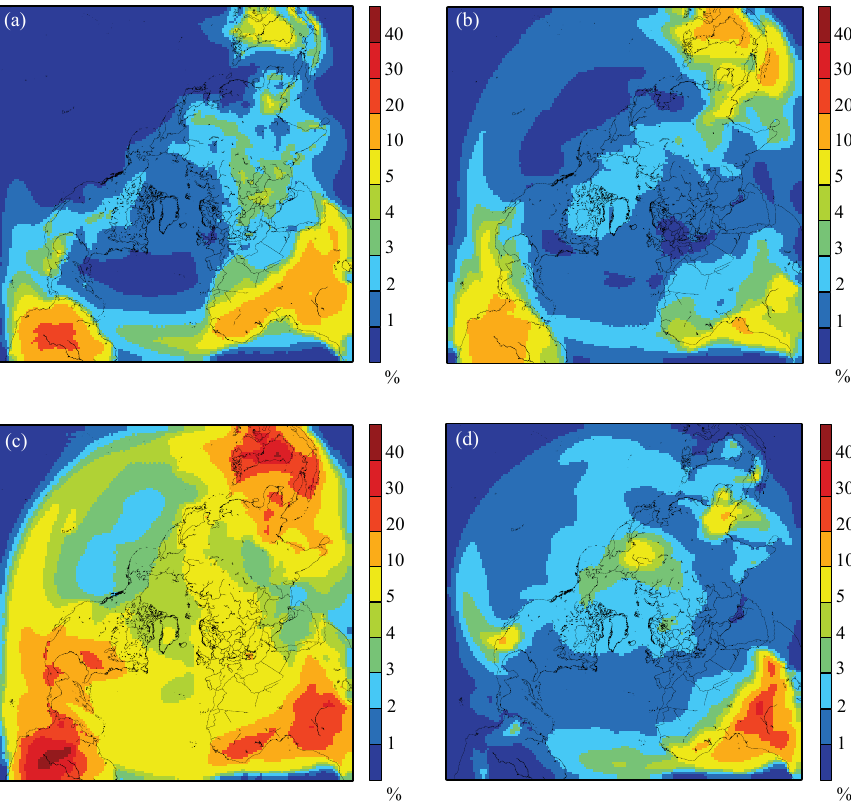
Fig. 12. Relative contributions (%) of the natural sources with emissions of (a) SNO x (NO x from soils), (b) LNO x (NO x from lightning), (c) biogenic VOCs, and (d) wildfire emissions to annual average ozone mixing ratios in